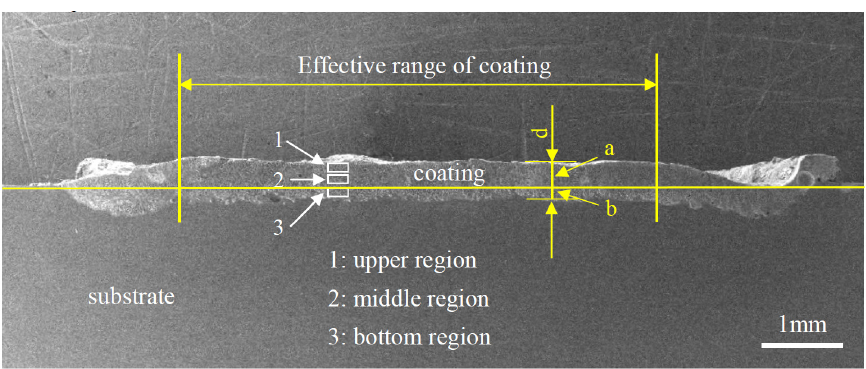
Figure 4. Typical cross-section morphology of the coating.